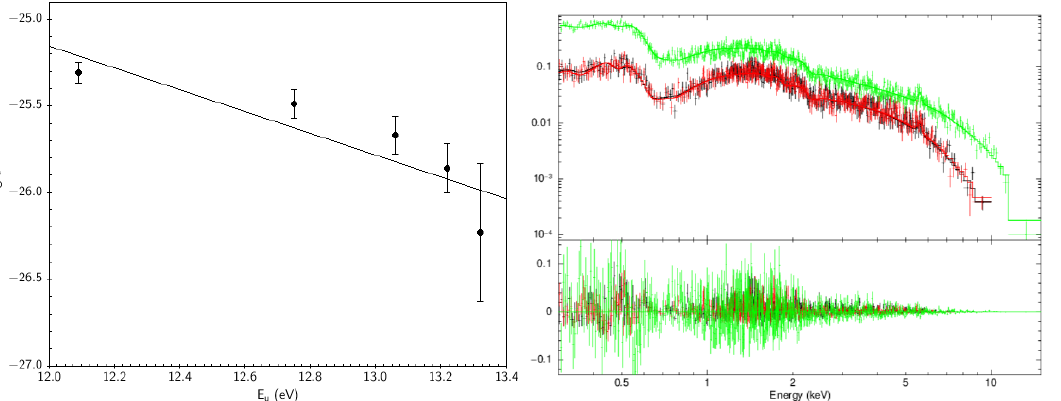
Figure 3. Suppression of high-order Balmer lines, observed through the normalized intensities of the broad components in the optical spectrum of PG 1114 + 445 ( left panel ), compared with the soft X-ray spectrum ( right panel ) obtained from the XMM Newton EPIC instrument (green points) and from the twin MOS cameras (red and black points). The X-ray spectrum is modeled with a power-law spectrum, a soft X-ray thermal excess and an ionized absorber. Absorption from the neutral medium within the Milky Way is also taken into